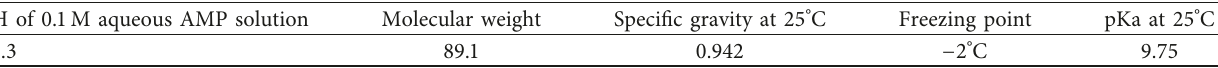
Table 7: Properties of the pH controller (AMP) used in the experiment.